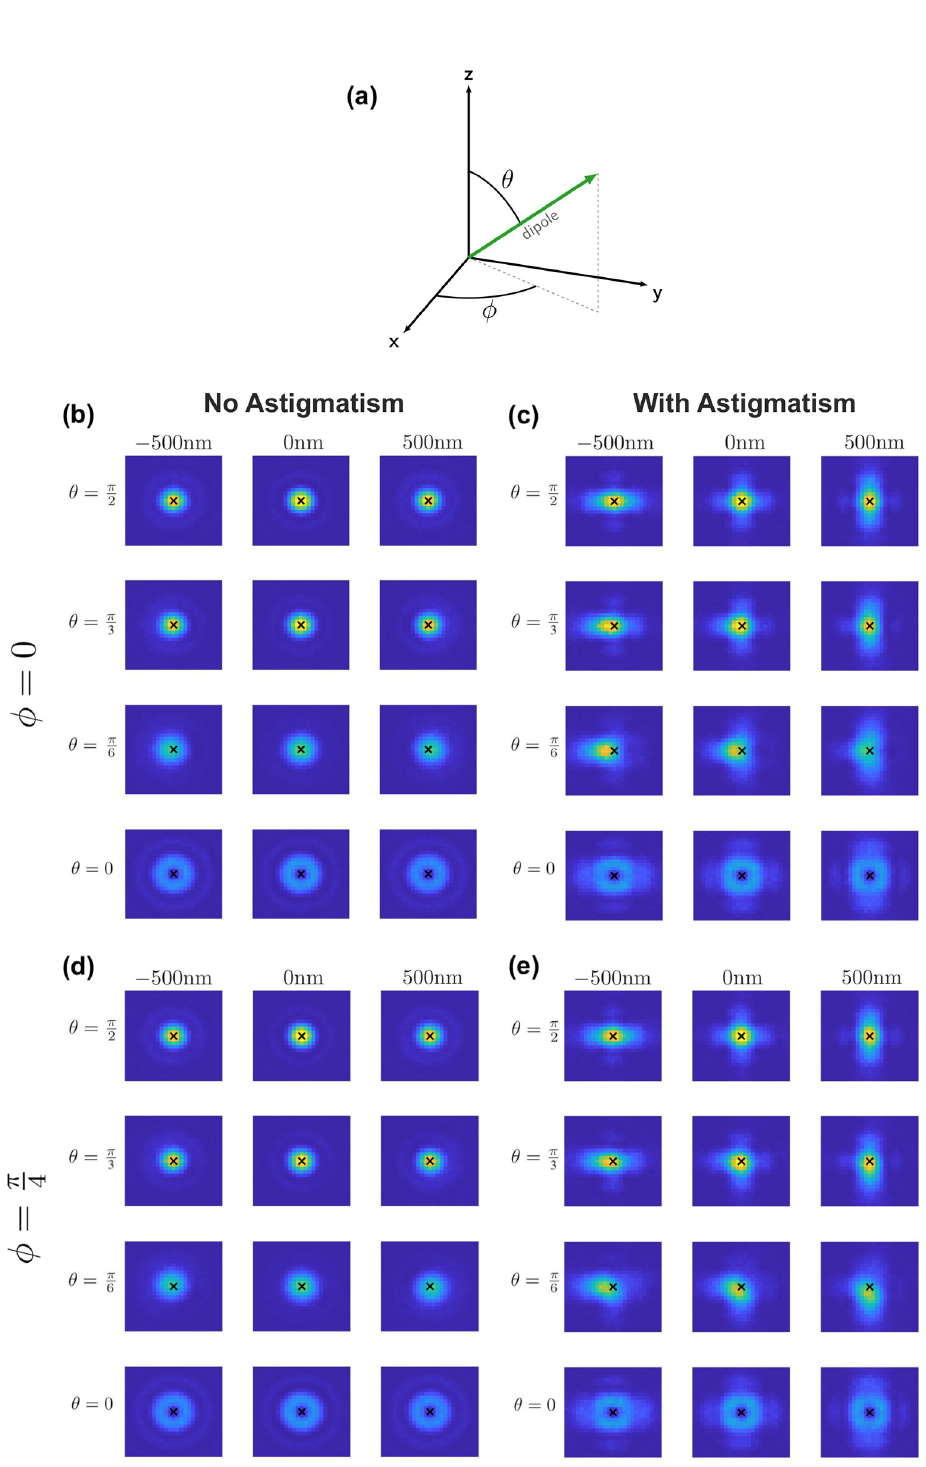
PLOS ONE | https://doi.org/10.1371/journal.pone.0263500 February 4,